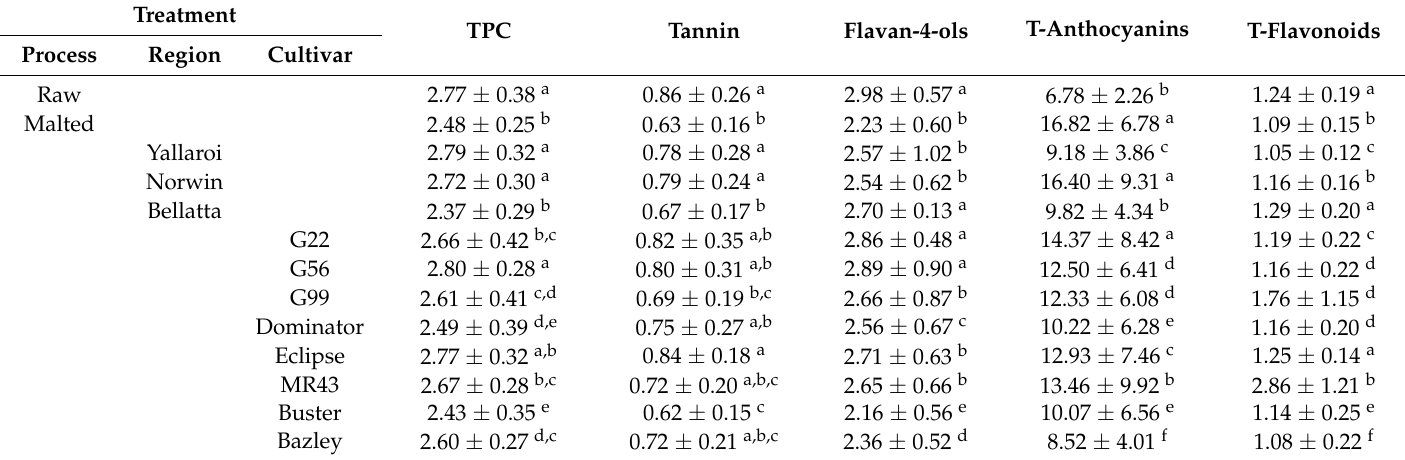
Table 3. Overall comparison of phenolics and antioxidant activity in raw versus malted grains, regions and cultivars of Australian sorghums. Values are means ±